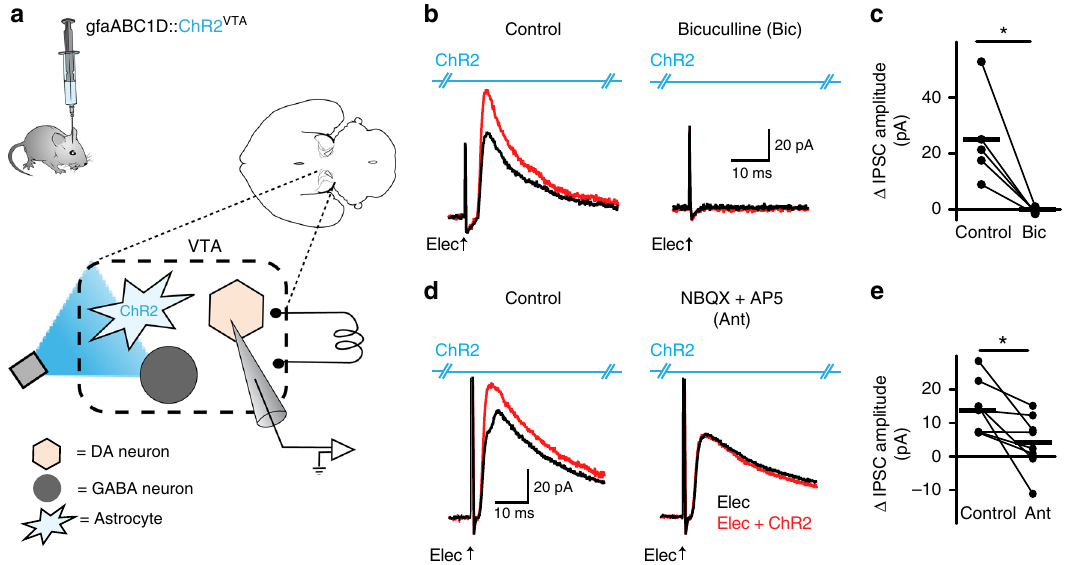
Fig. 4 Increase in dopamine neuron inhibition is dependent on glutamate receptor activation. a Schematic showing the microcircuitry of the VTA and manipulations performed. b On the left is a voltage-clamp (V h = + 10 mV) recording from a VTA dopamine neuron where pairing electrical simulation (Elec., black traces) with ChR2 stimulation on VTA astrocytes (red traces) causes an increase in IPSC amplitude. On the right, when the GABA A antagonist, bicuculline (30 µ M), is added during the same recording the IPSC is abolished. c Data summarizing the effect of bicuculline. d The increase in IPSC amplitude was eliminated by glutamate receptor antagonists (10 µ M NBQX + 100 µ M AP-5) with no effect on the amplitude of the IPSC elicited by electrical stimulation alone (black traces) (paired t -test, P = 0.99, n = 8 cells, 4 mice). e Data summarizing the effect of glutamate receptor antagonists.